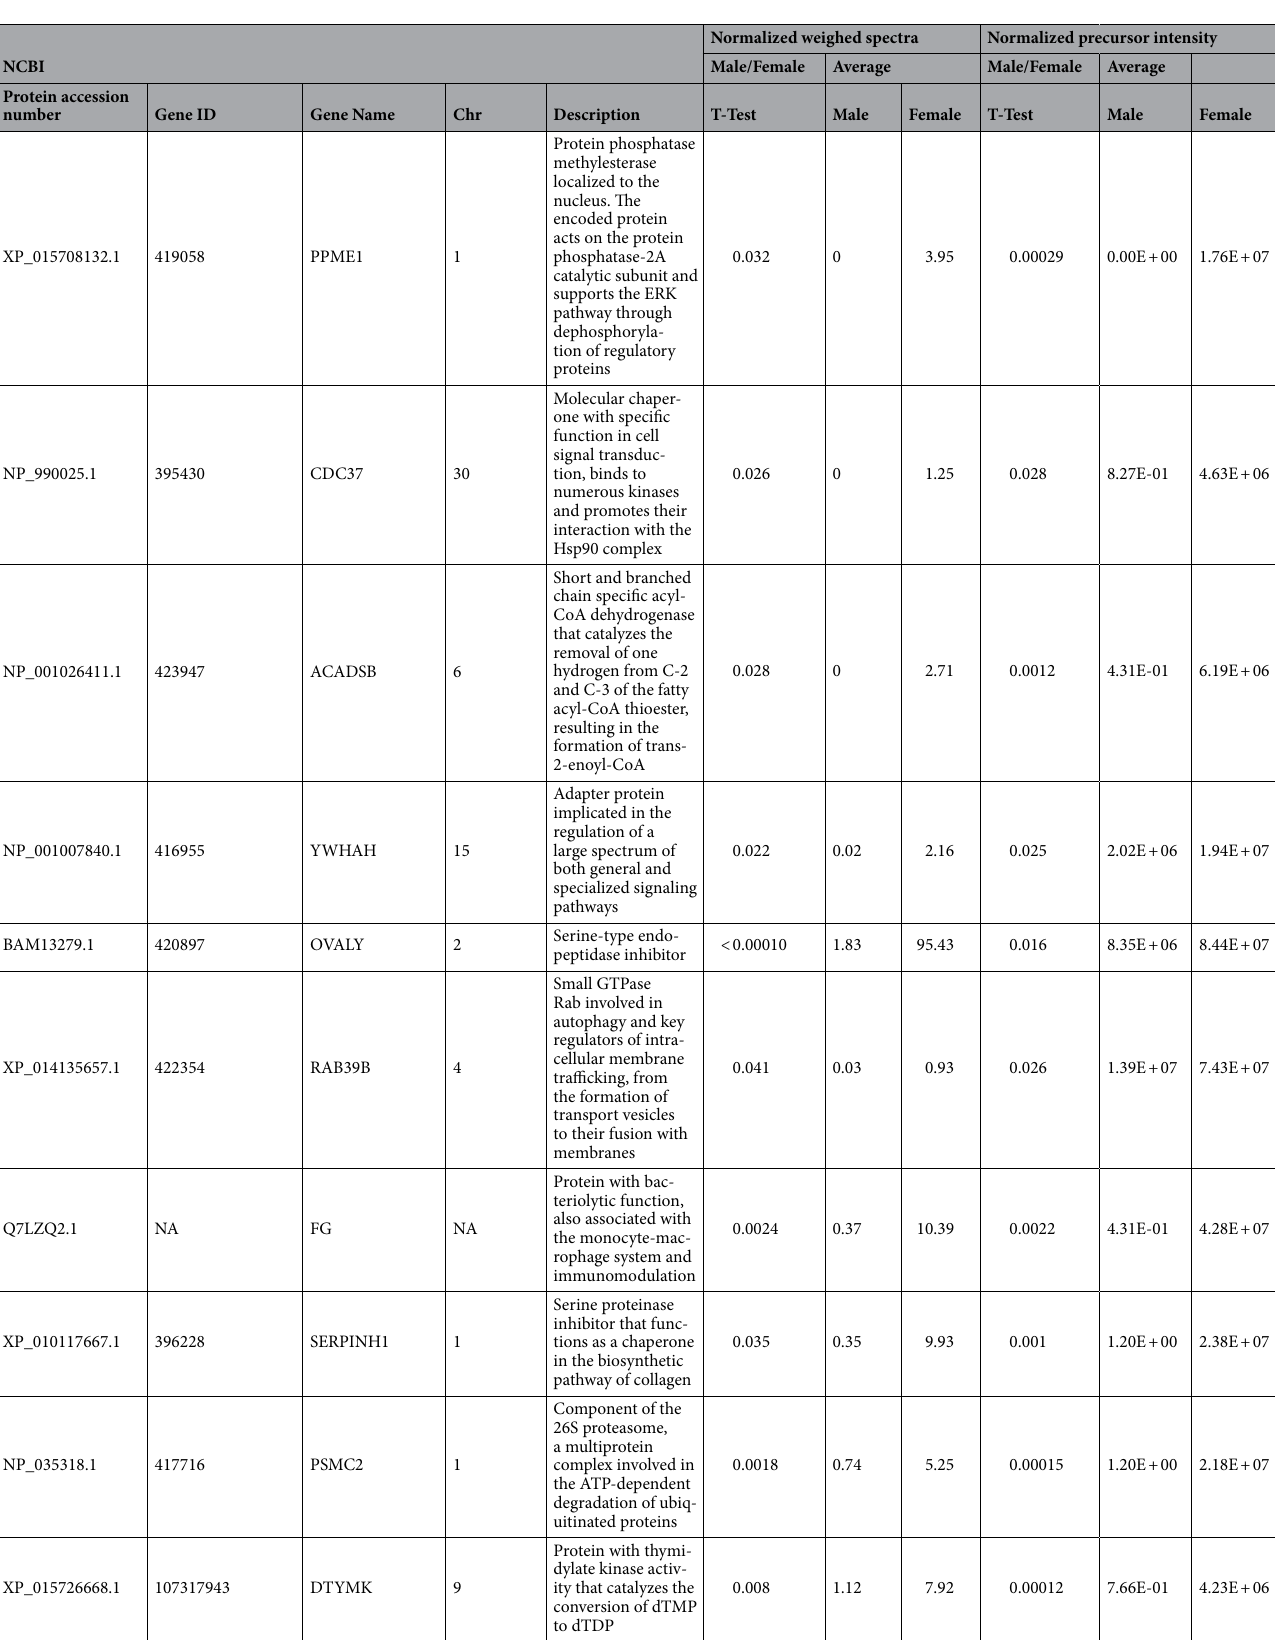
Table 1. Top forty differentially abundant proteins in male and female PGCs identified by two quantitative methods: WS and